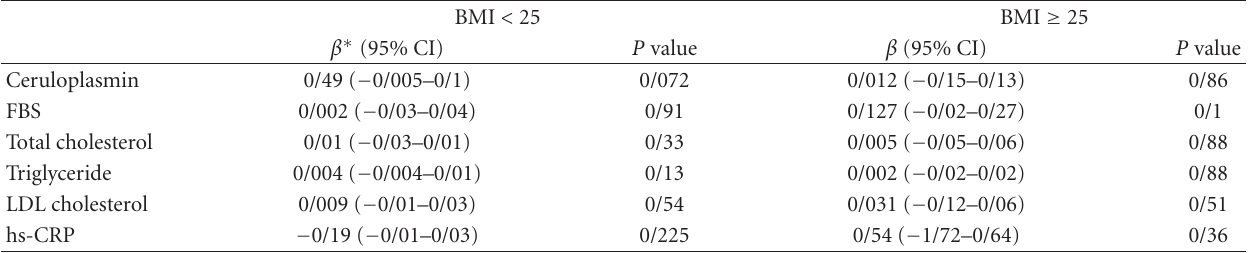
Table 3: BMI in relation to serum ceruloplasmin level and other variables, in case and control group separately. Results for linear multiple regression